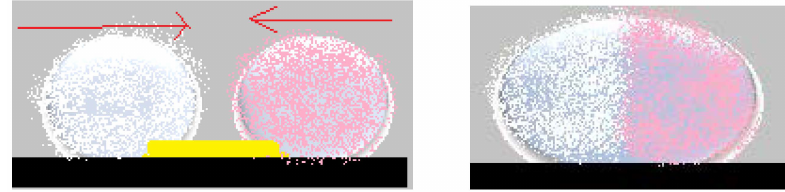
Figure 6. Coalescence of liquid marbles covered in Lycopodium (pink), respectively in PVDF (white), through a glass bar.